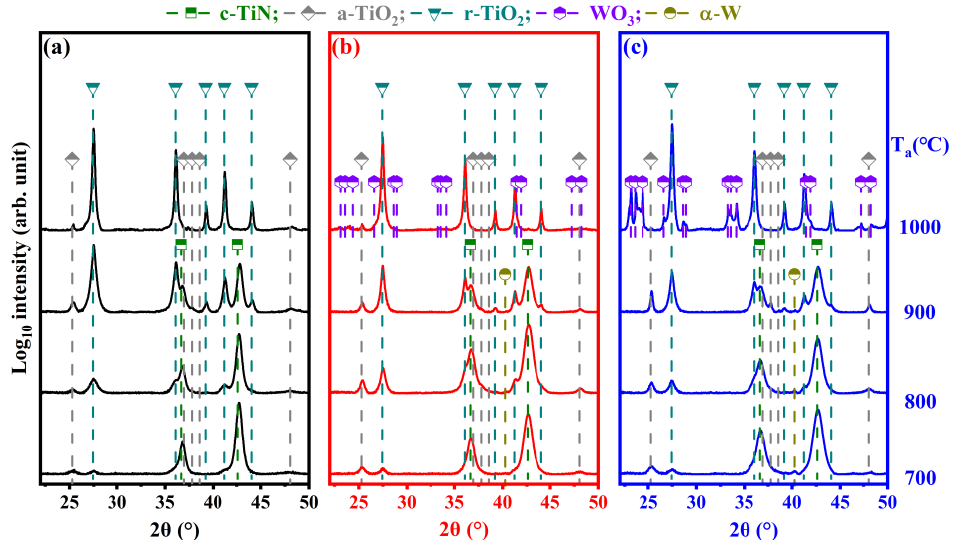
Figure 8. XRD diffractograms of ( a ) Ti 0.88 Si 0.12 N, ( b ) Ti 0.88 Si 0.08 W 0.04 N, and ( c ) Ti 0.84 Si 0.09 W 0.07 N pow- dered coatings after oxidation at indicated temperatures. powdered coatings after oxidation at indicated